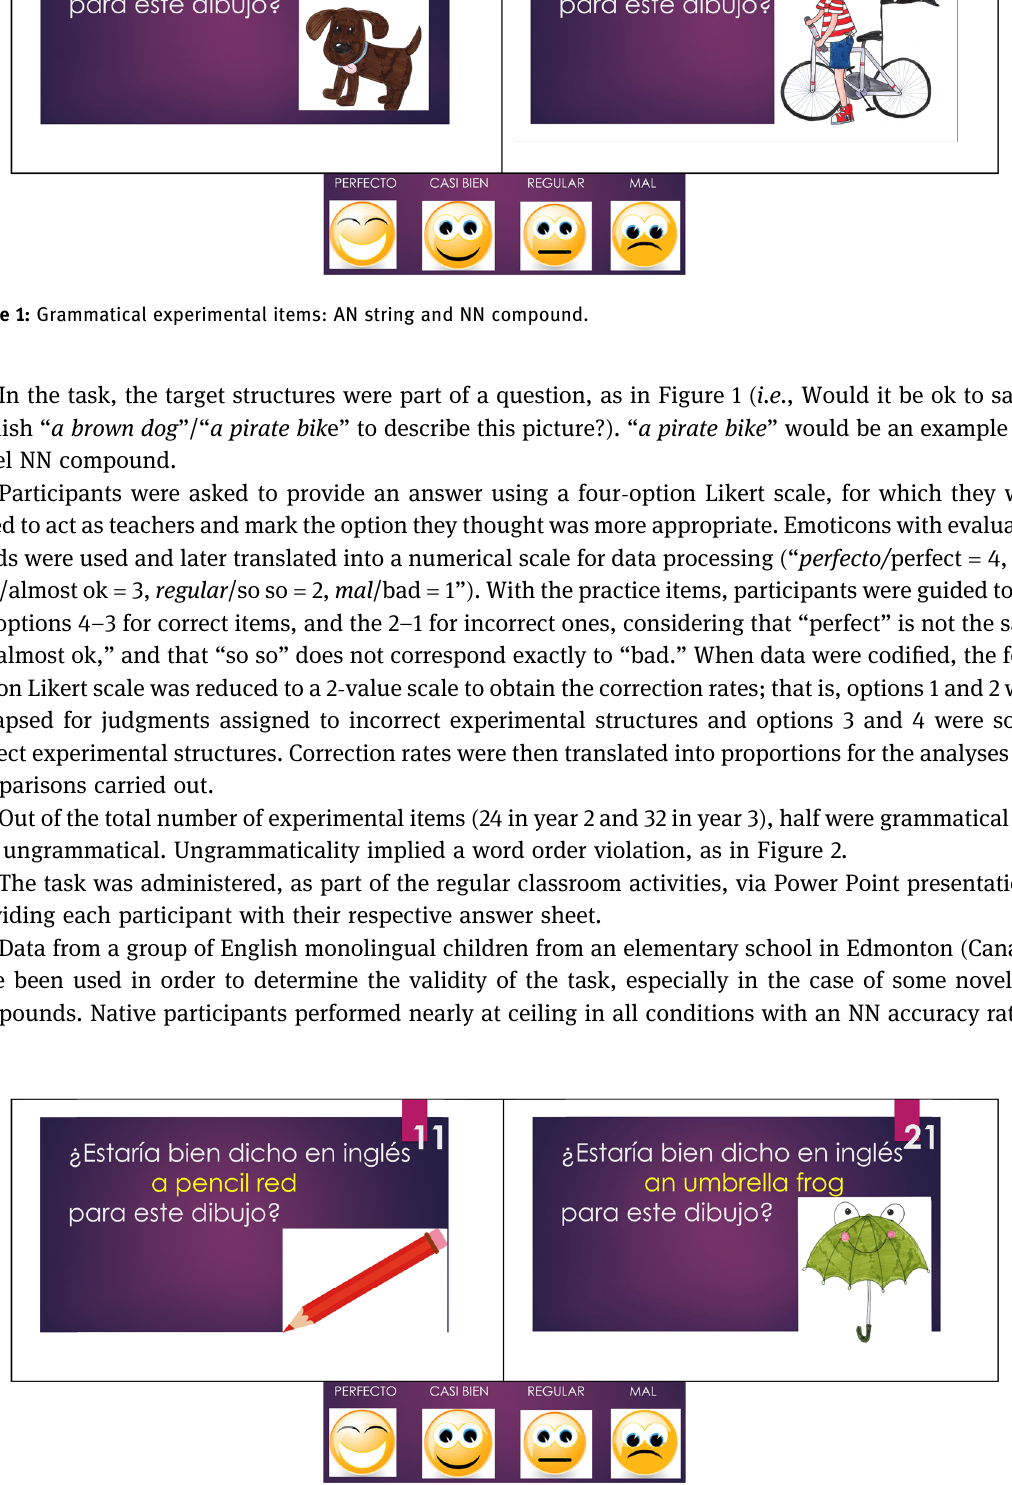
Figure 2: Ungrammatical experimental items: AN string and NN